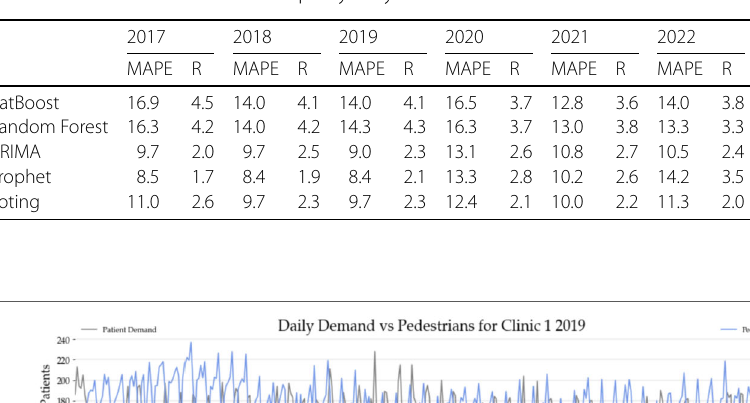
Table 12 MAPE accuracies for the proxy-only models for Clinic 1